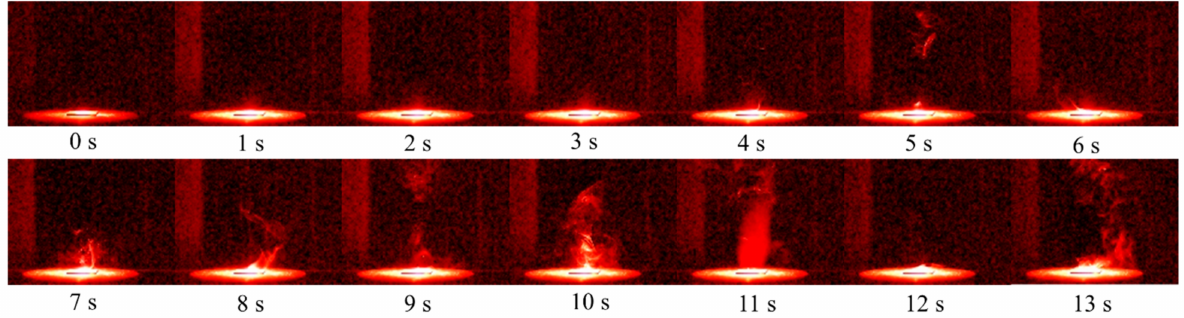
Figure 3. Ignition process of RDX at 298